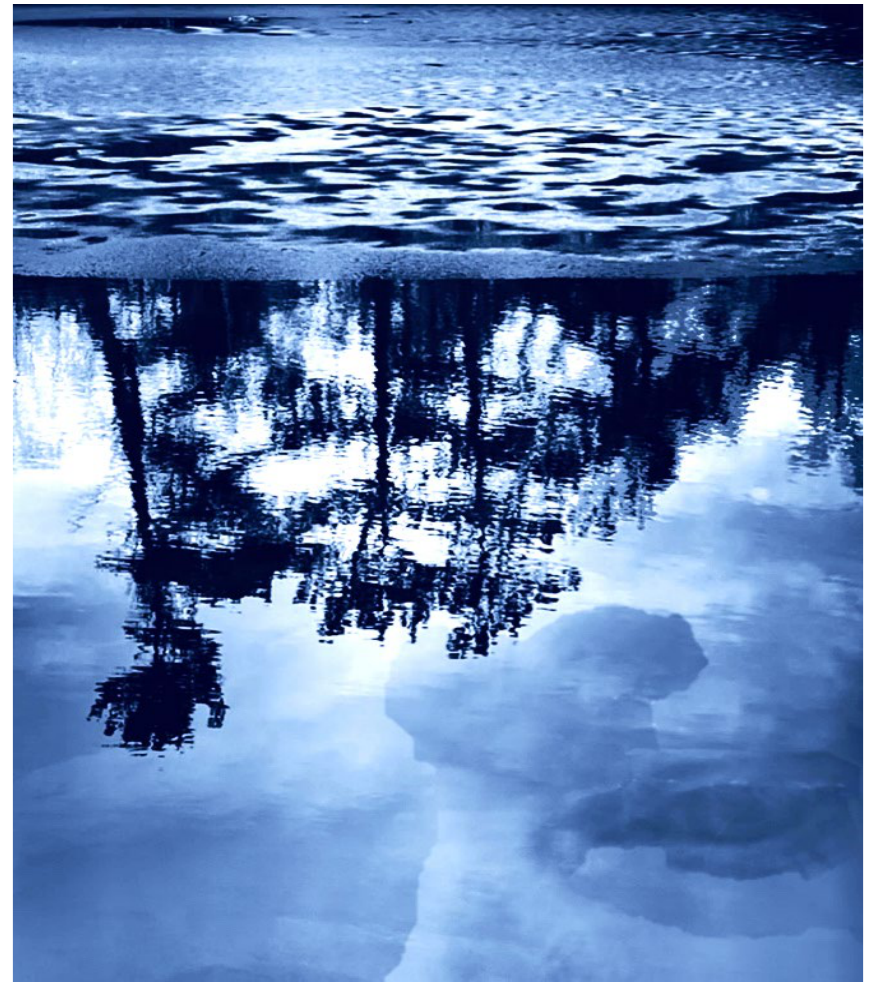
Figure 1. Embodied Vulnerability and